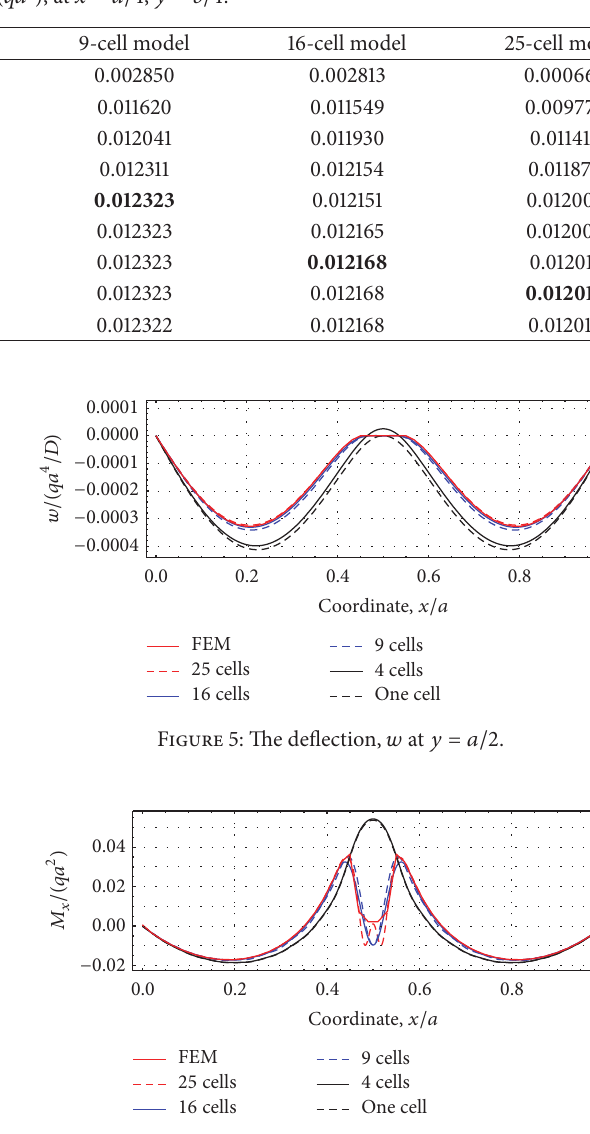
Figure 6: The bending moment 𝑀 𝑥 at 𝑦 = 𝑎/2